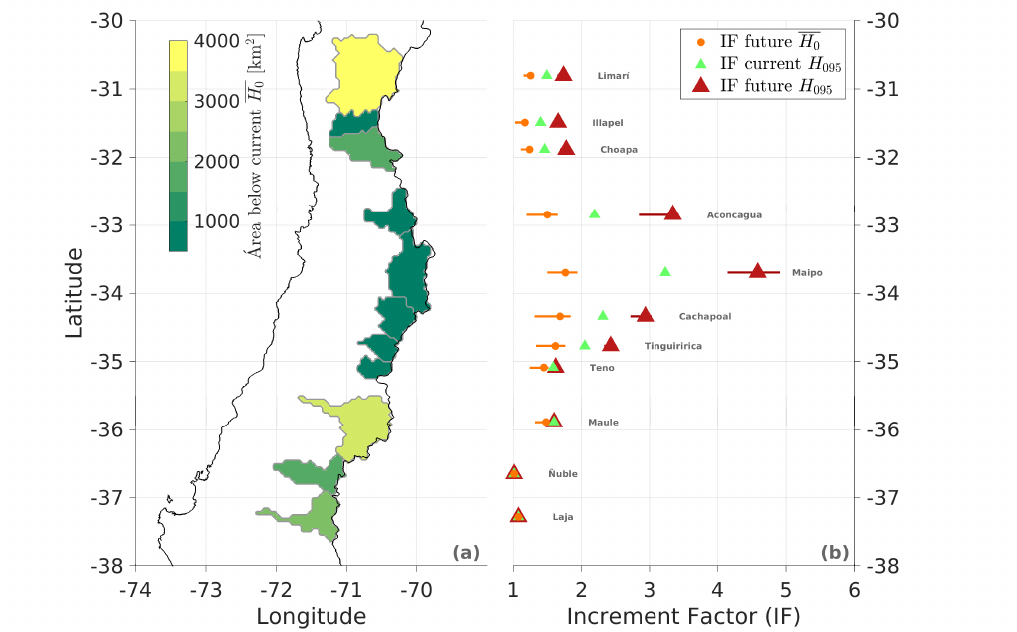
Figure 8. ( a ) Area between 1000 m ASL and below the mean of H 0 in current climate for selected basins in central Chile basins. ( b ) Increment factor of the area considering future H 0 values (mean and 95th percentile). See Section 4.3 for details. Lines in panel ( b ) indicate the range of models for each